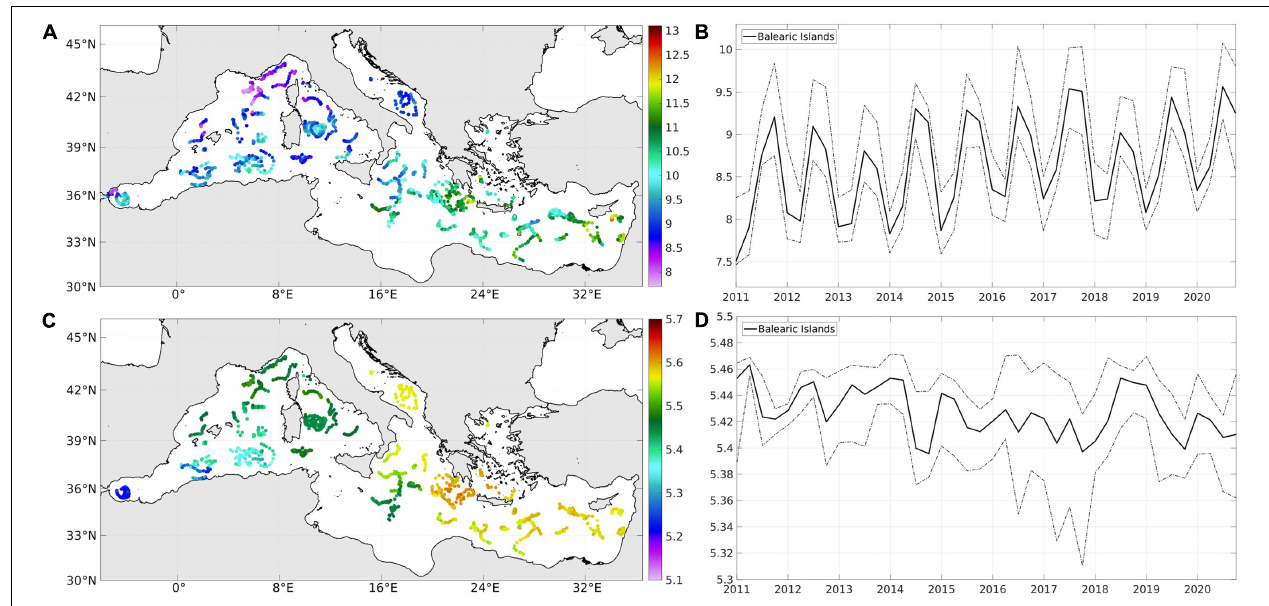
FIGURE 8 | Illustrations for the seasonal OHC (in GJ/m 2 ) (A,B) and OSC (in Mg/m 2 ) (C,D) integrated within [10–150 m]: 2D maps of OHC (A) and OSC (C) in autumn 2020, time series of the medians (solid lines), 17 and 83th percentiles (dashed lines) of seasonal OHC (B) and OSC (D) in the Balearic Islands since